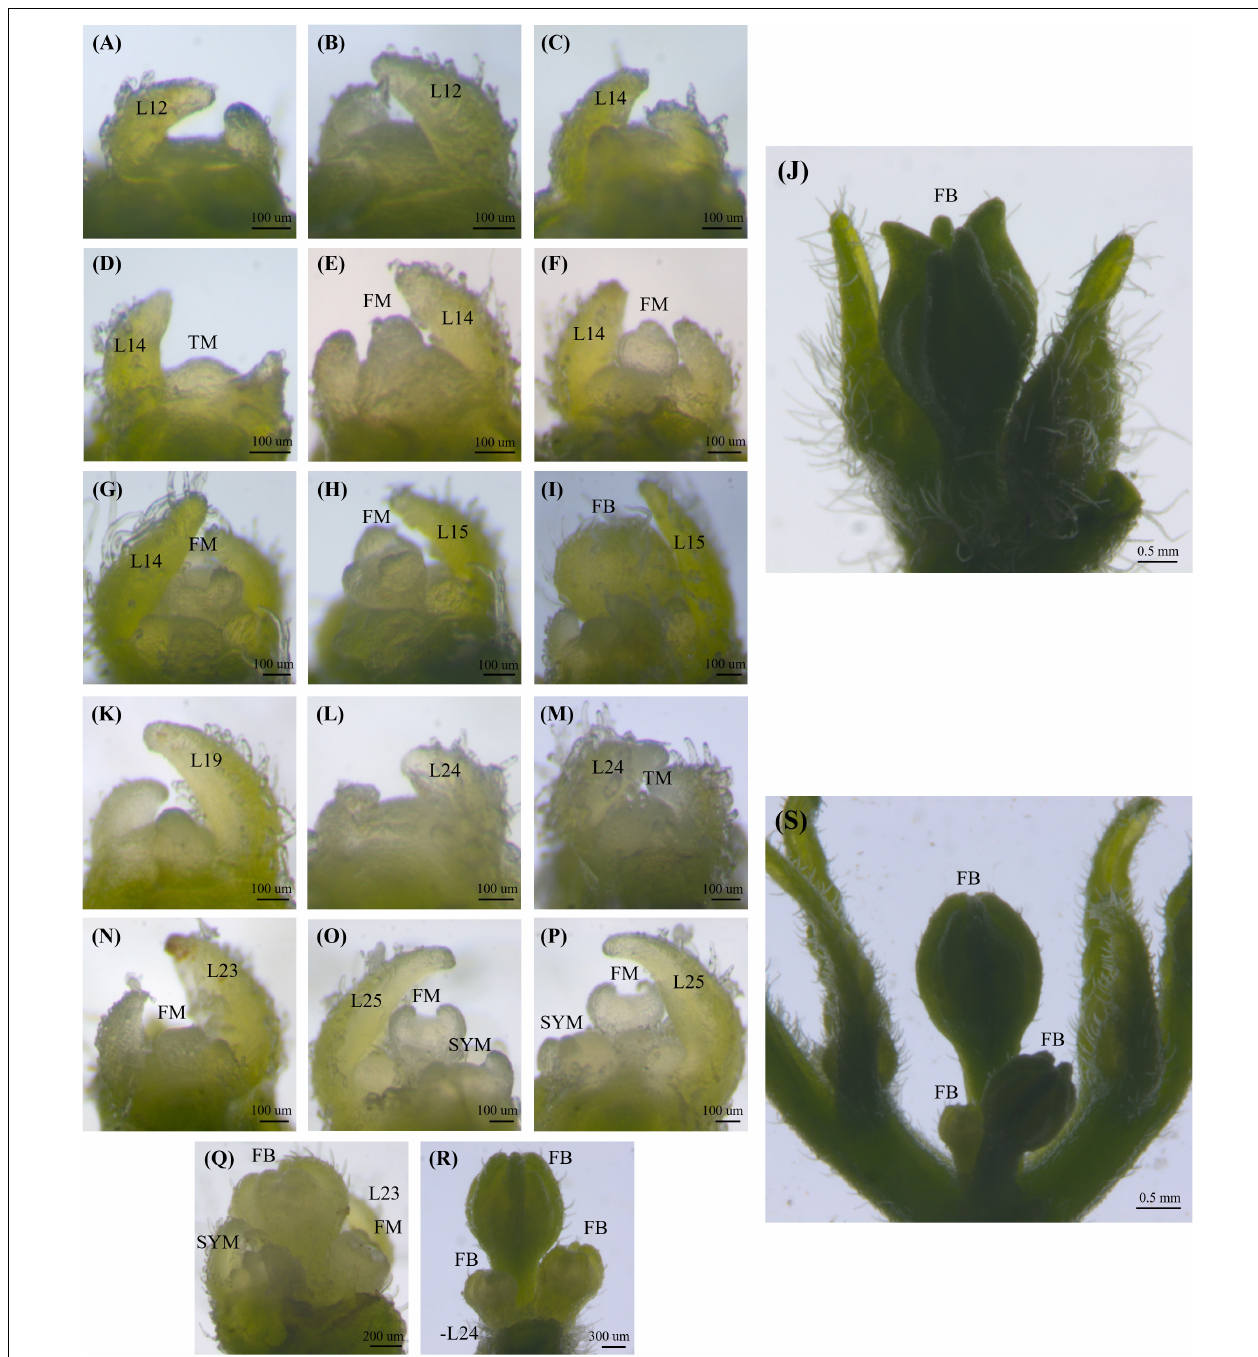
FIGURE 1 | Shoot apical meristem and flowering pattern in the ‘TF68’ (A–J) and ‘Habanero’ (K–S) parental accessions. Leaf number is indicated by L, the transition meristem stage is marked by TM, the flower meristem is marked by FM, flower buds are marked by FB and the sympodial meristem is indicated by